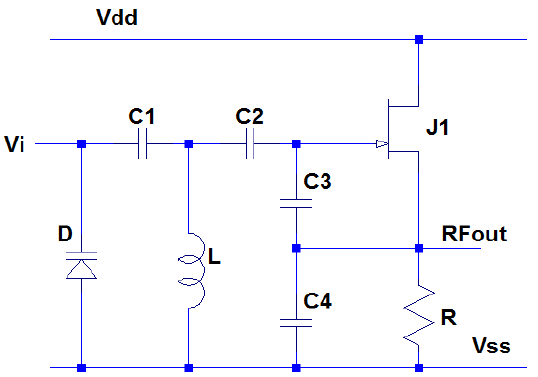
Figure 11. The circuit schematic of high temperature SiC JFET Clapp